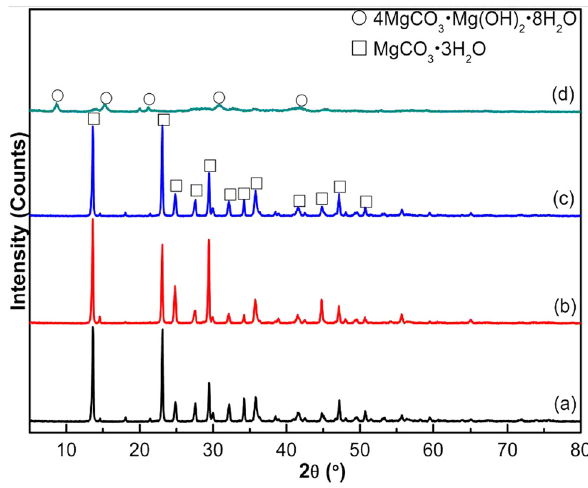
Figure 6: XRD patterns for the carbonation products with di ff erent carbonation temperatures: ( a ) 40°C, ( b ) 50°C, ( c ) 60°C, and ( d ) 80°C.